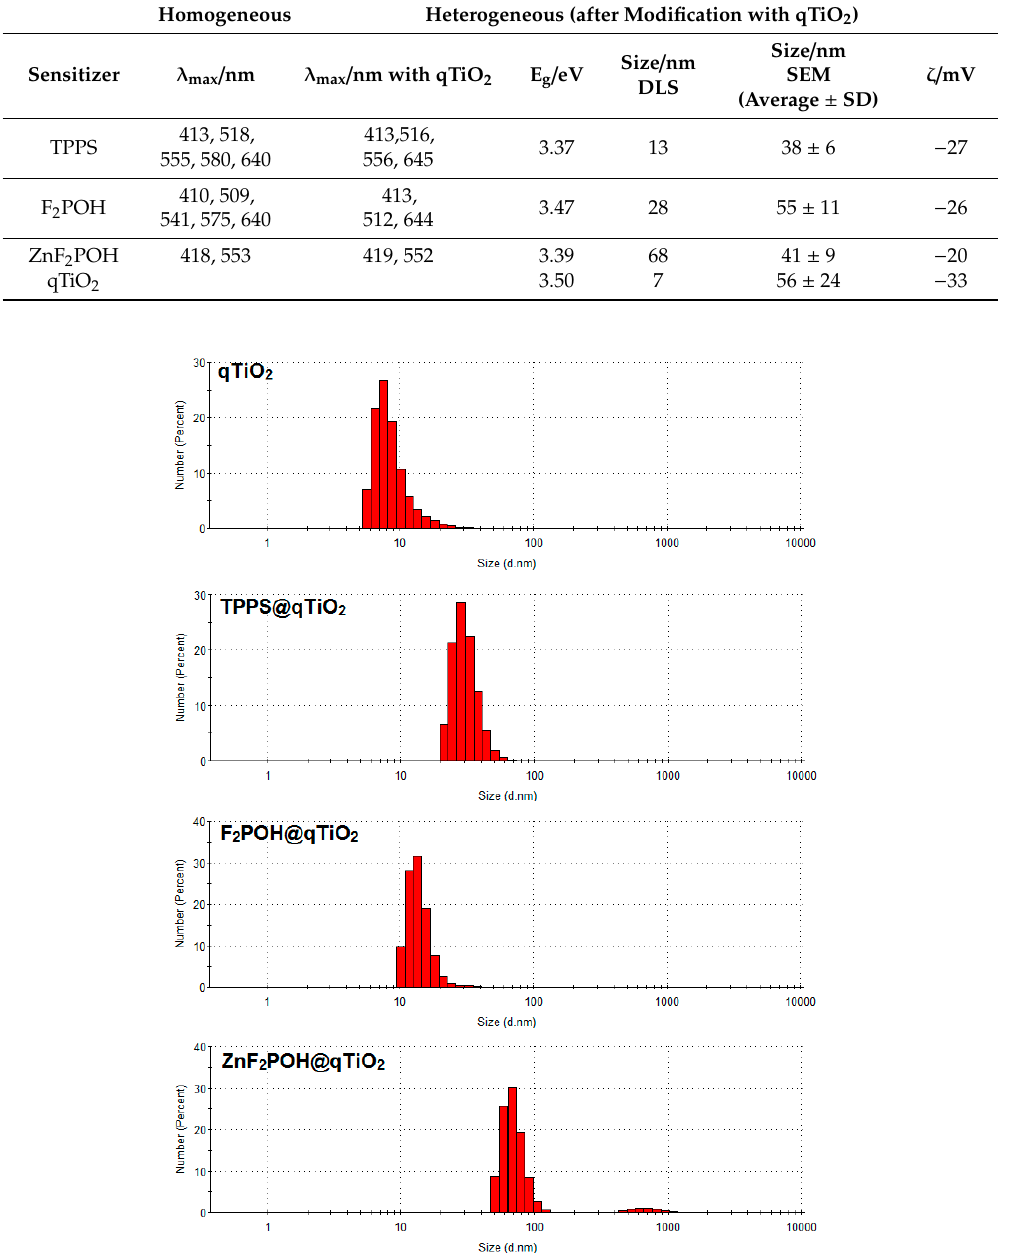
Table 1. Spectroscopic properties of sulfonyl porphyrin derivatives, mean hydrodynamic diameters, average size of aggregates from scanning electron microscopy (SEM) and zeta potential in water (pH = 6). qTiO 2 : colloidal form of titanium dioxide, DLS: dynamic light scattering.